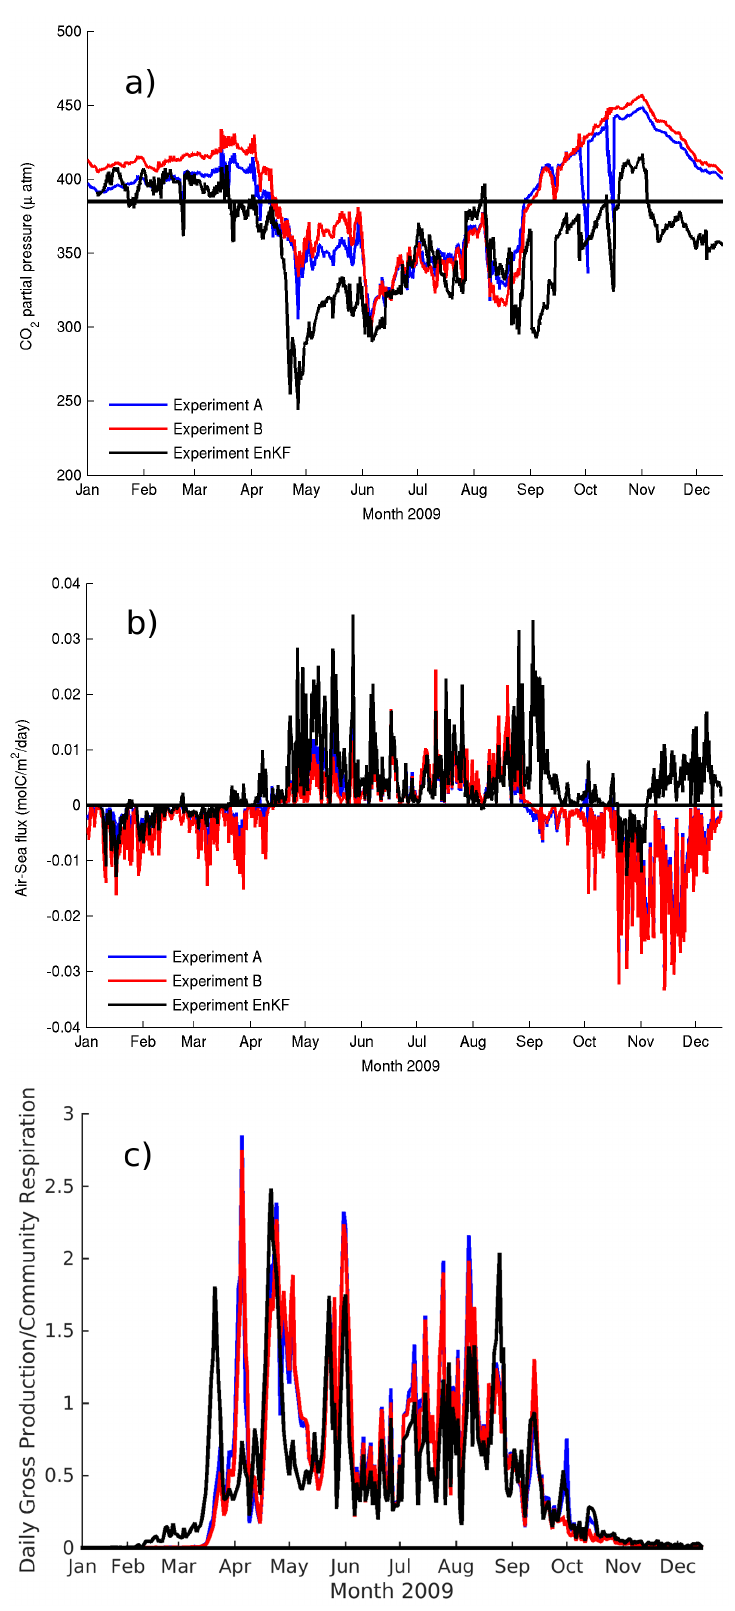
Figure 10. Time evolution of ( a ) near-surface pCO 2 , ( b ) air–sea flux of CO 2 and ( c ) water column average of Gross Production and Community Respiration ratio for Experiments A, B and D. The black line in at 385 in ( a ) represents the atmospheric pCO 2 value used in the